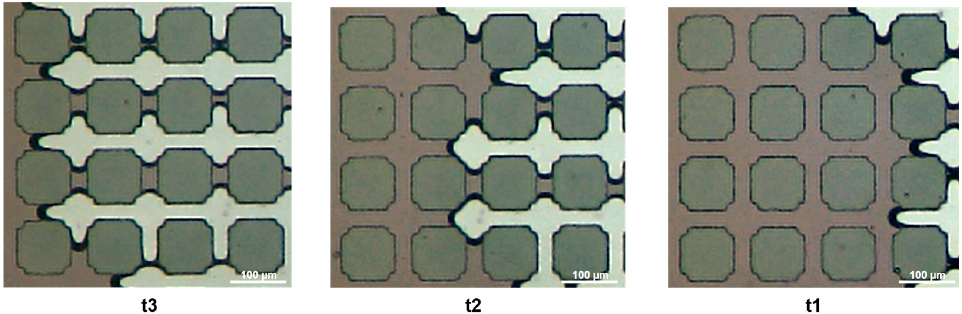
Figure 16. Evolution of the gas front during the drainage process on GRID01.